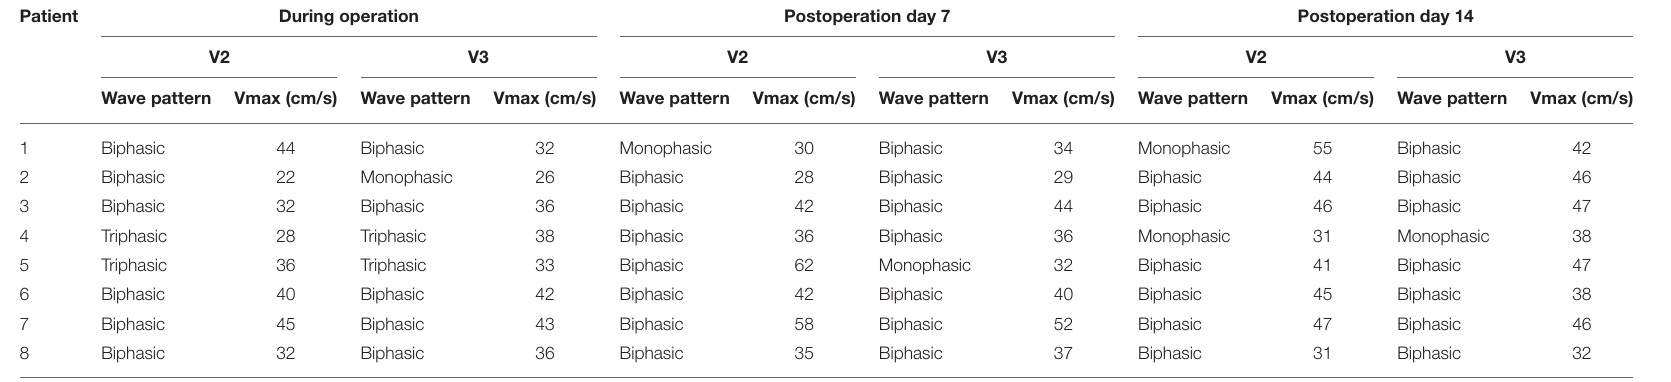
TABLE 3 | Postoperational Doppler ultrasound profile for hepatic vein flow.